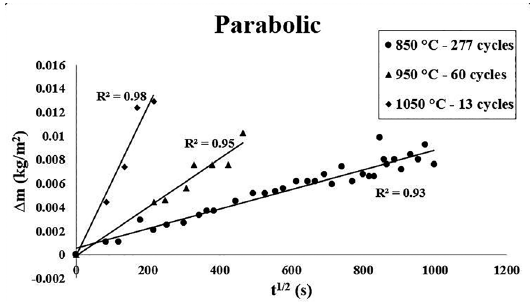
Figure 8. Parabolic kinetic determination for the FeSiCrNi alloy.